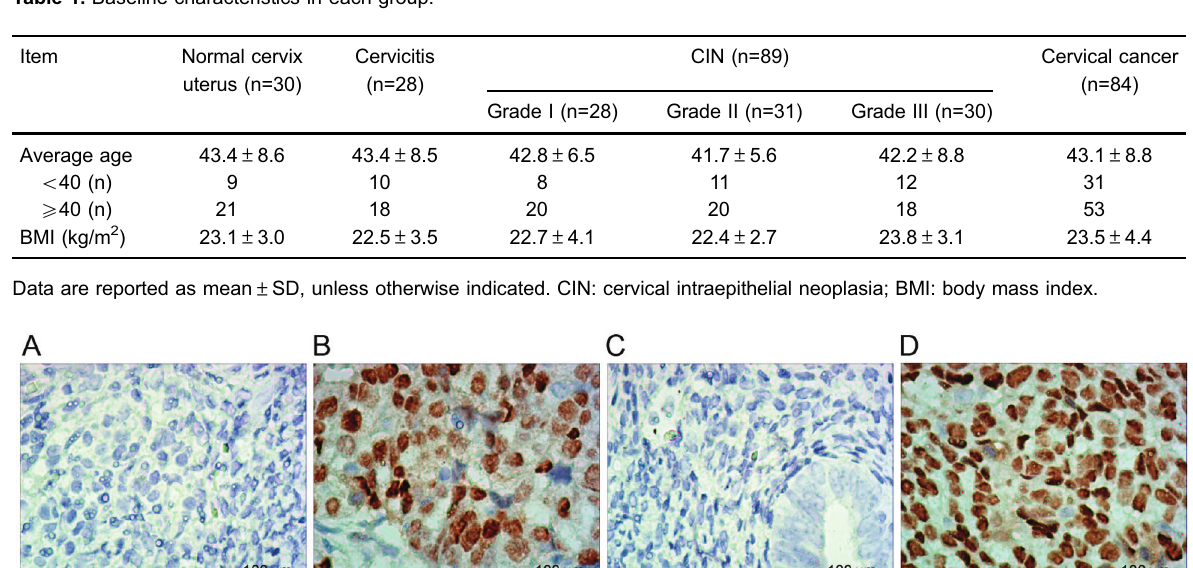
Table 1. Baseline characteristics in each